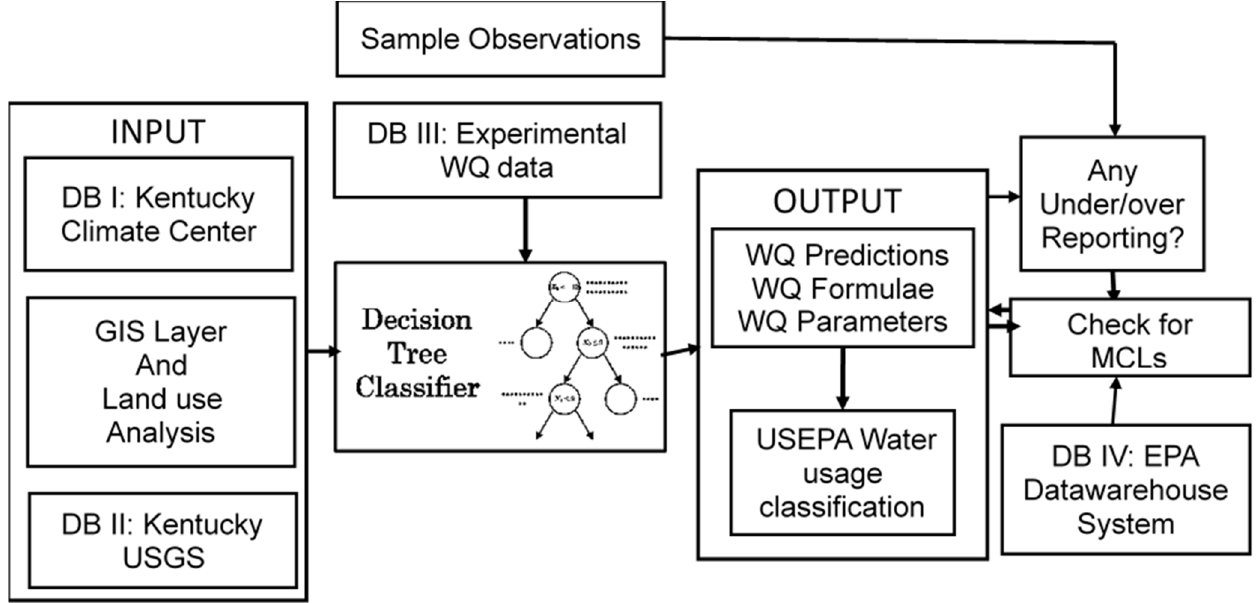
Figure 10. Decision Tree Classifier based Decision Support System (DTCDSS).